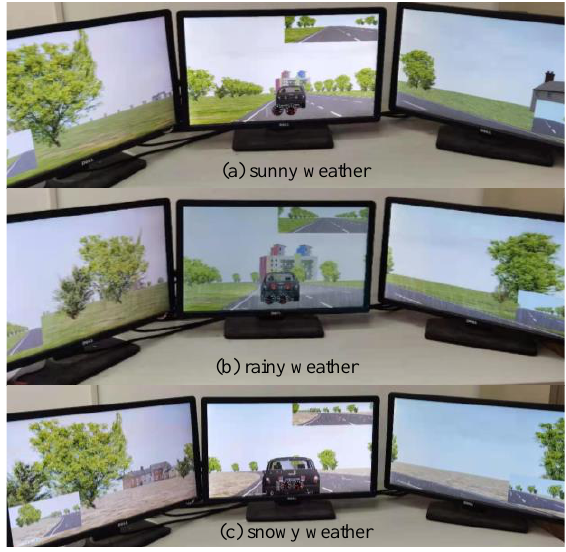
Table 1. Driving simulation scenarios.